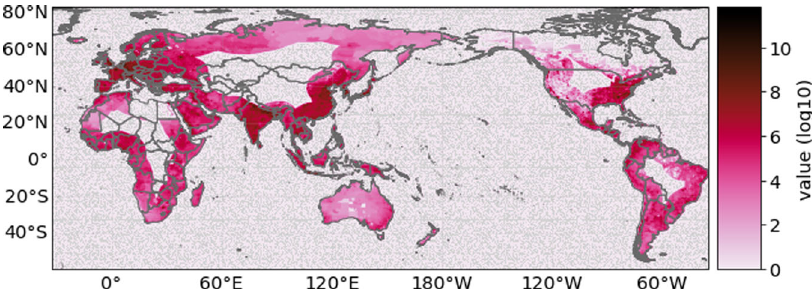
Fig. 5 | Global distribution of asset exposure value. Data is given in log10 USD based on the LitPop 45 method with an inland distance to the coast of